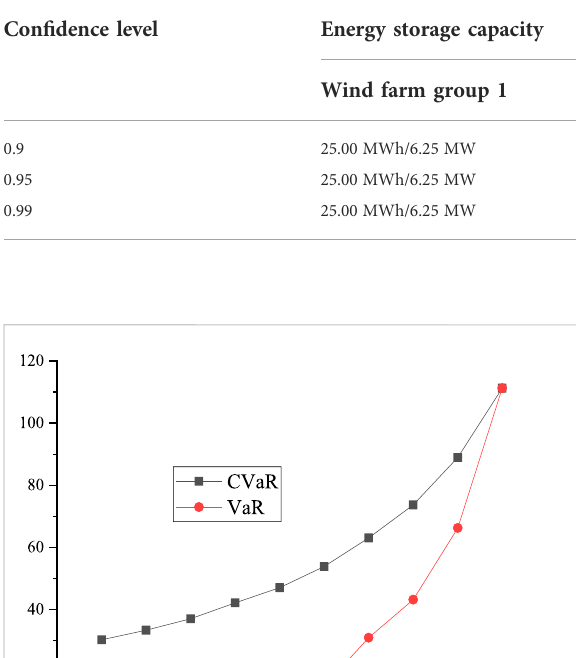
TABLE 3 Solution results.